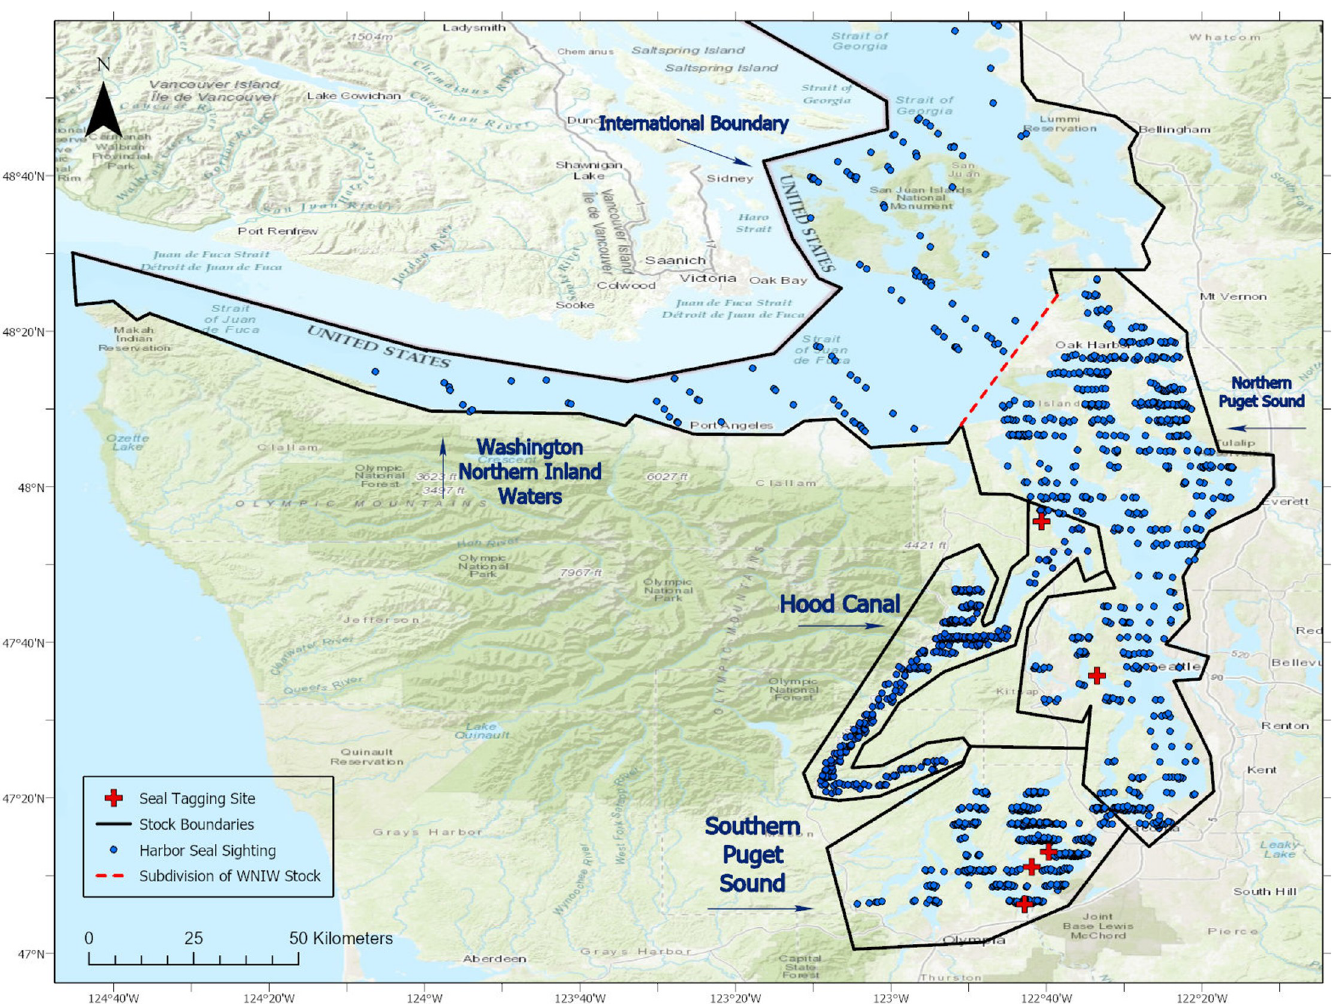
Fig 2. Map showing the locations of harbor seal sightings used for estimating density and abundance in this study (i.e., after filtering). Map was created using ArcGIS 1 software by Esri. ArcGIS 1 and ArcMap ™ are the intellectual property of Esri and are used herein under license. Copyright © Esri. All rights